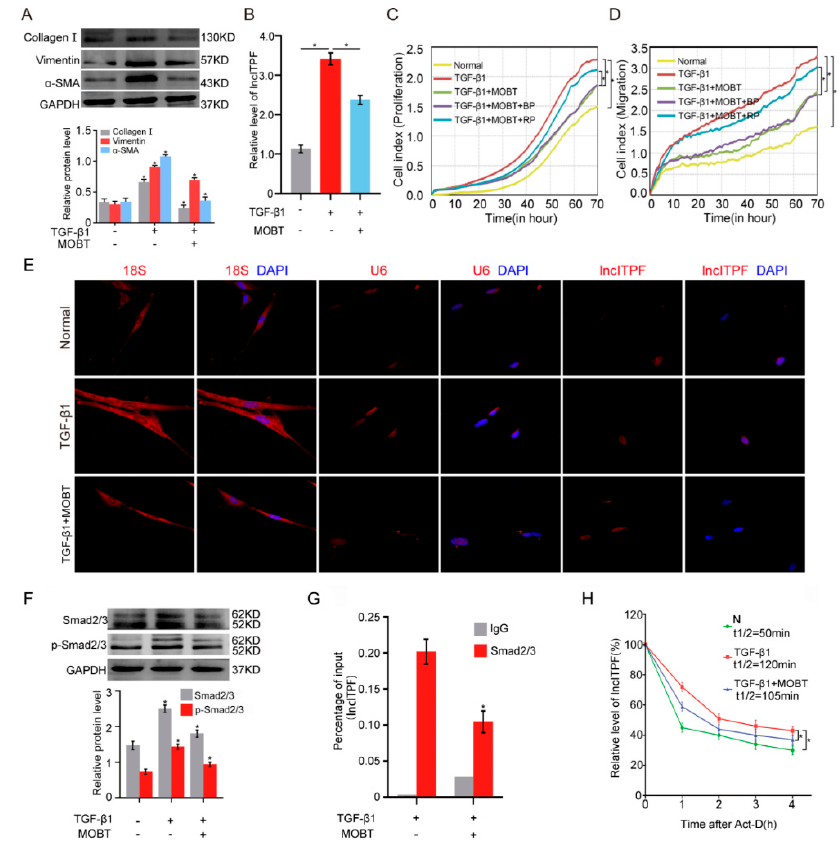
Figure 3. MOBT inhibited lncITPF transcription via reducing Smad2/3 phosphorylation. ( A ) The Western blot analysis displayed that TGF- β 1 increased the expression of collagen I, vimentin,